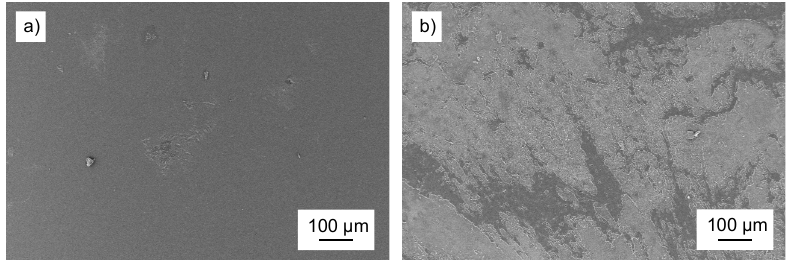
Figure 3. SEM micrographs for comparison of the ( a ) control PET surface and ( b ) PET surface of PET*96 h after incubation.